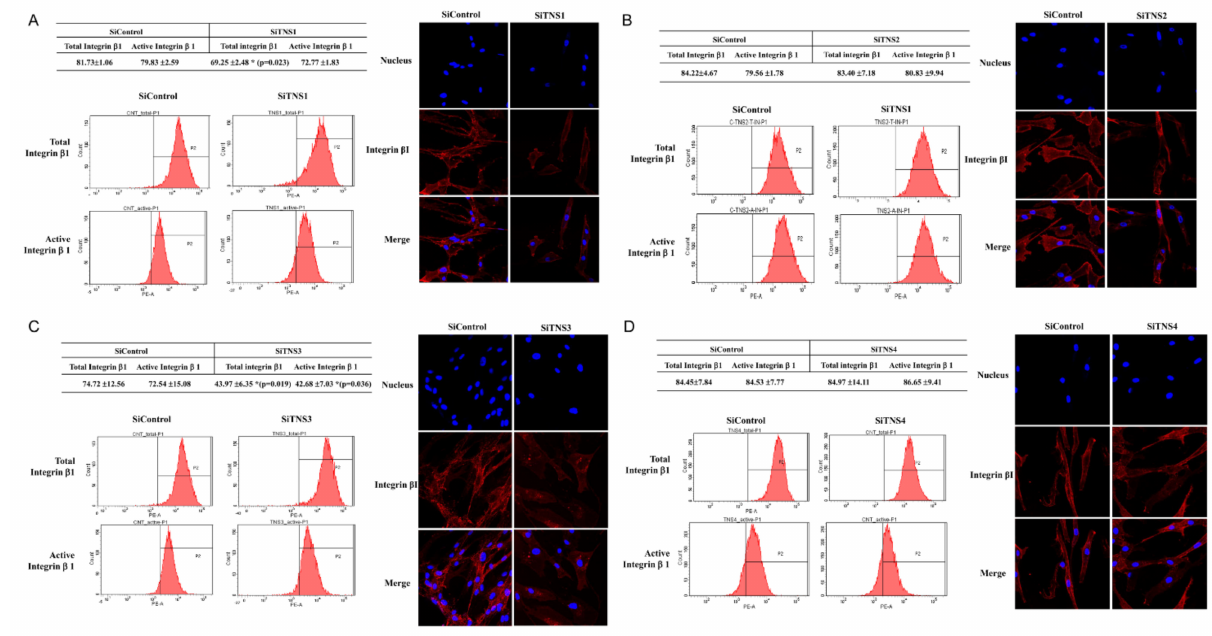
Figure 6. TNS3 in focal adhesion regulates integrin activity in tonsil mesenchymal stem cells. ( A – C ) Flow cytometric analysis revealed no significant change in active ITG β 1 levels in siTNS1-, siTNS2-, and siTNS3-treated cells compared to that in siControl-treated cells. ( D ) Transfection with siTNS3 led to a significant reduction in total and active ITG β 1 according to flow cytometry analysis (left panels). siTNS3-transfection also weakened active ITG β 1 staining in immunofluorescence assays. ITG β 1, which was mainly distributed at the edge of the cell, was expressed near the nucleus after siTNS3-treatment (right panels). * p < 0.05, compared to siControl. n =